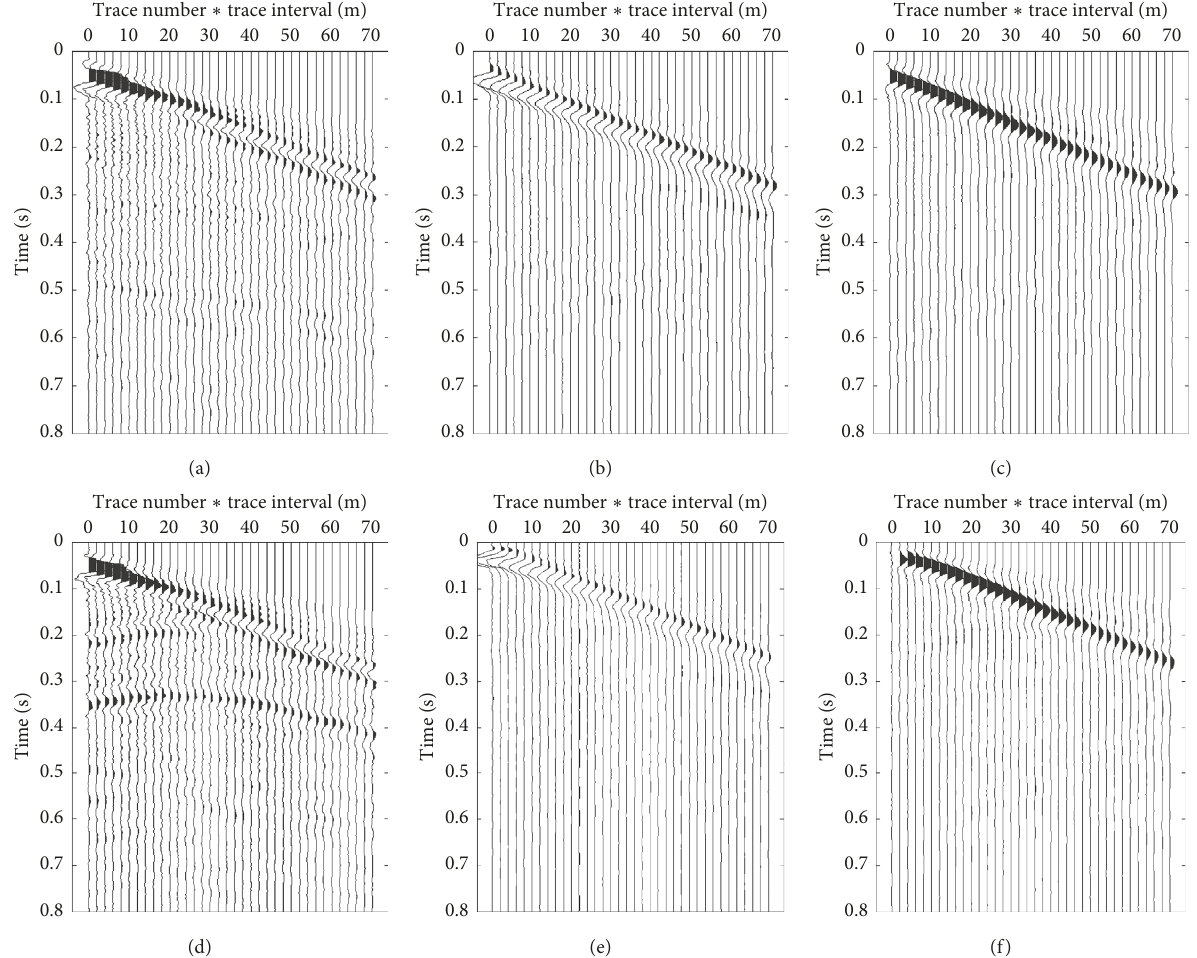
Figure 4: Time-history profile of the earth-rock dams with/without hidden hazards at the same measuring line. (a) Displacement in x direction in a case with no hazards. (b) Displacement in y direction in a case with no hazards. (c) Displacement in z direction in a case with no hazards. (d) Displacement in x direction in a case with hazards. (e) Displacement in y direction in a case with hazards. (f) Displacement in z direction in a case with